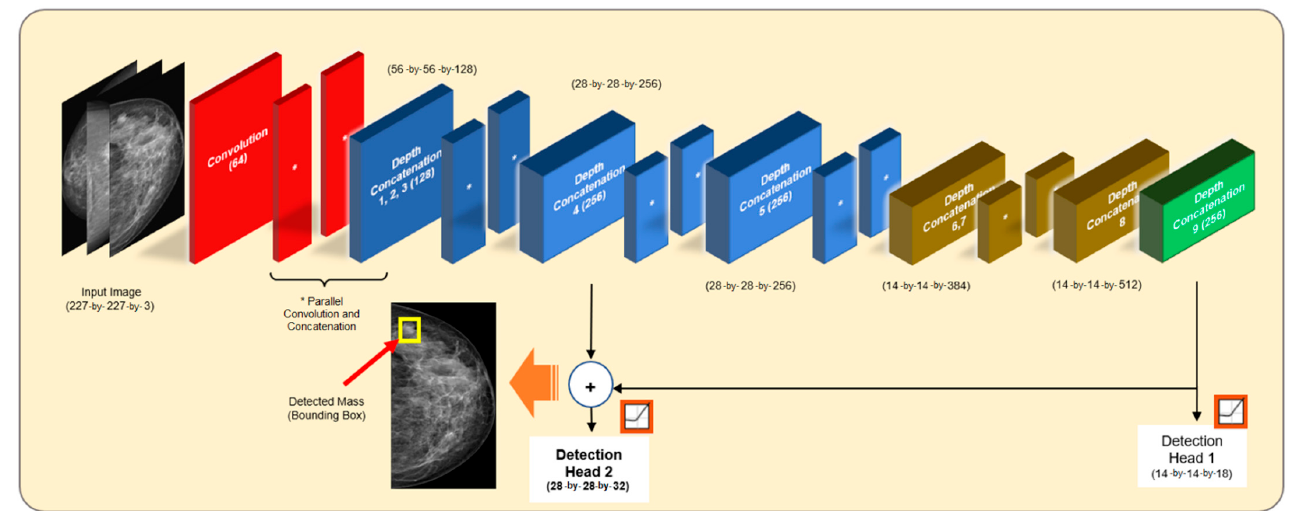
Figure 4. Modified SqueezeNet CNN architecture used for YOLOv3 training. The modified layer is in the Bold setting.